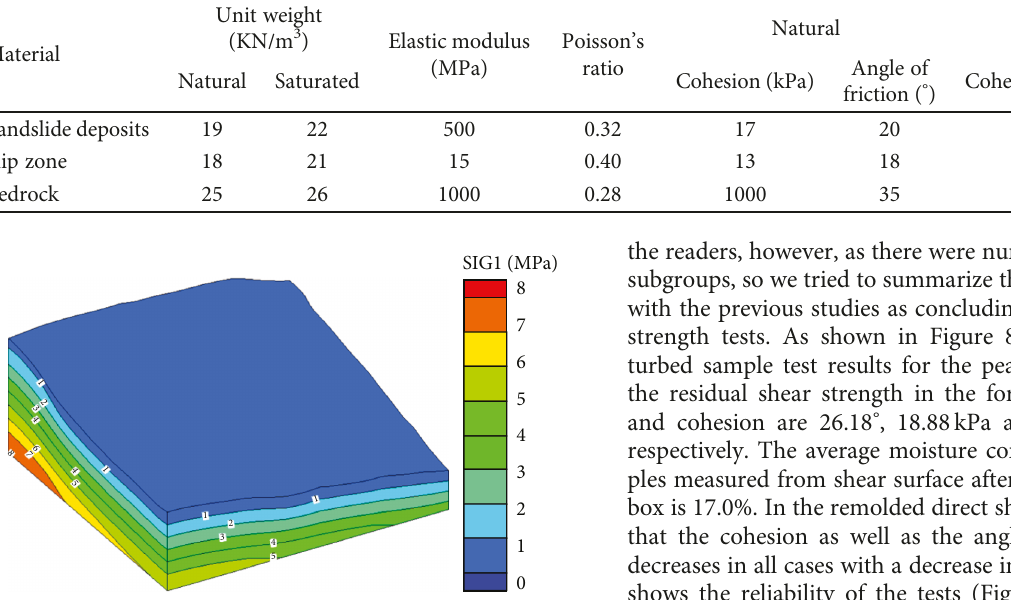
Figure 18: Maximum principal stress of Dasha landslide under the